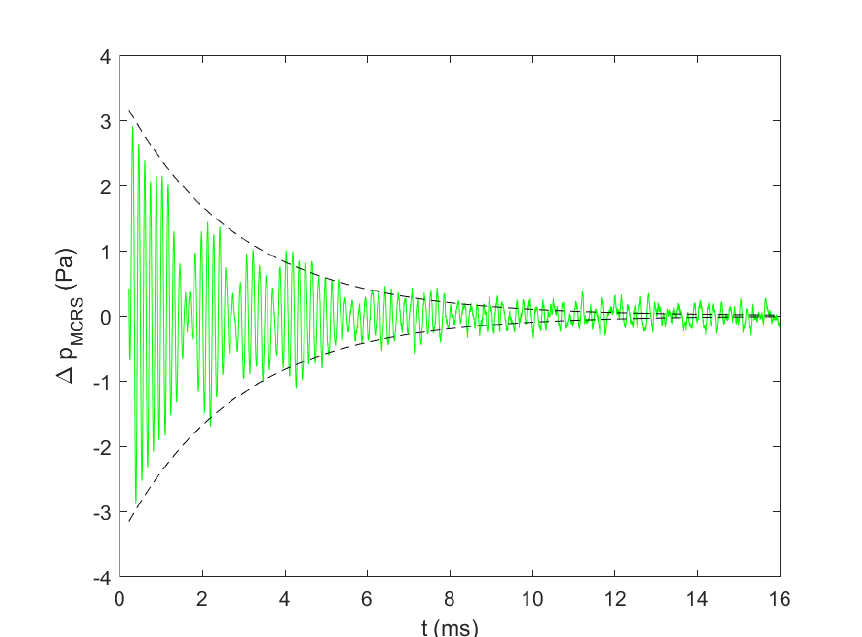
Figure 8. The evolution of the pressure difference caused by acoustic waves. The dashed lines are there to guide the eye. B. Platier, T. J. A. Staps, C. C. J. M. Hak, J. Beckers, and W. L. IJzerman, Plasma Sources Science and Technology, https://doi.org/10.1088/1361-6595/ab7d8e, 2020; licensed under a Creative Commons Attribution (CC BY)